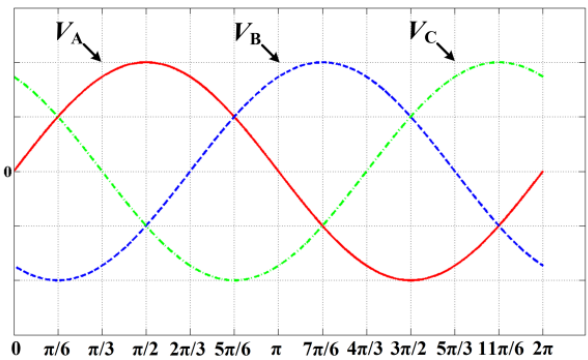
Figure 10. The waveform of the input